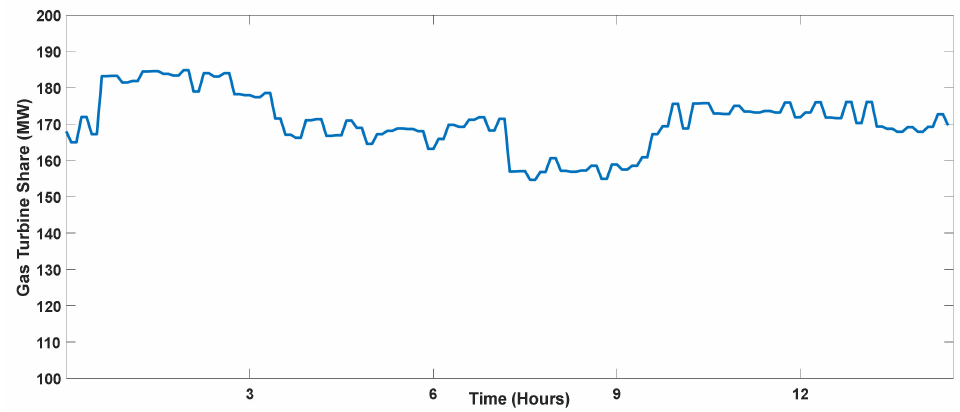
Figure 13. Output power share of the gas turbine.